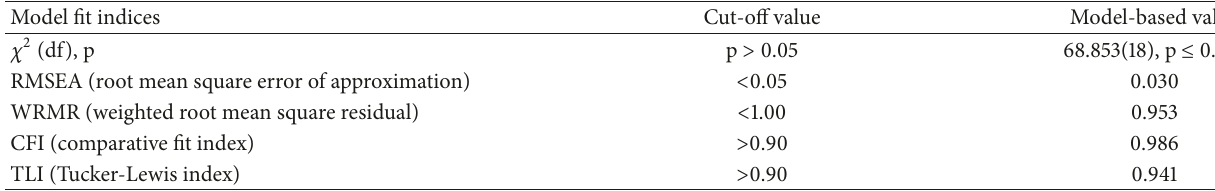
Table 2: Model fit indices for the car ownership and use